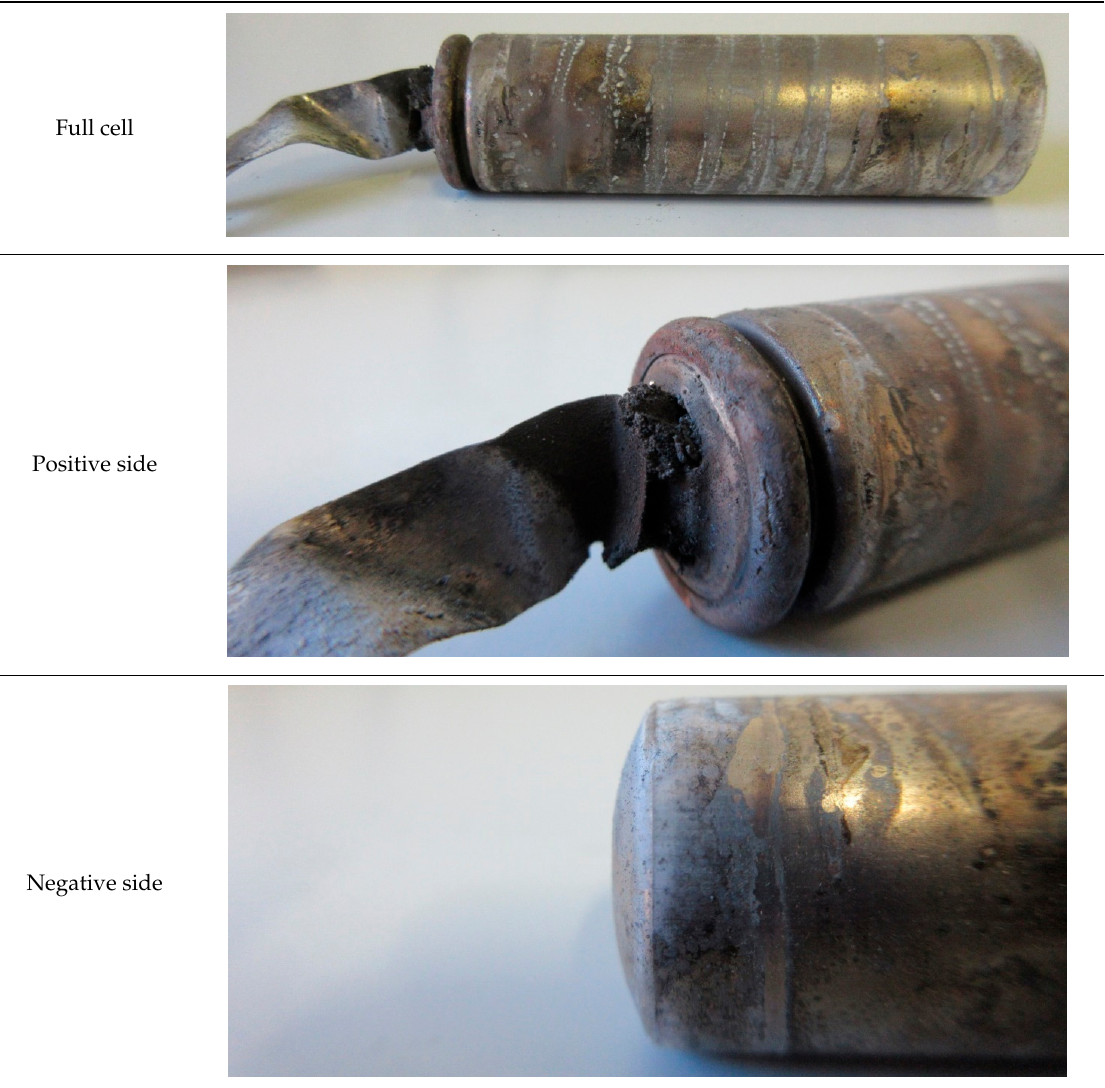
Table A3. Thermally abused Panasonic NCR GA at 100% SOC.